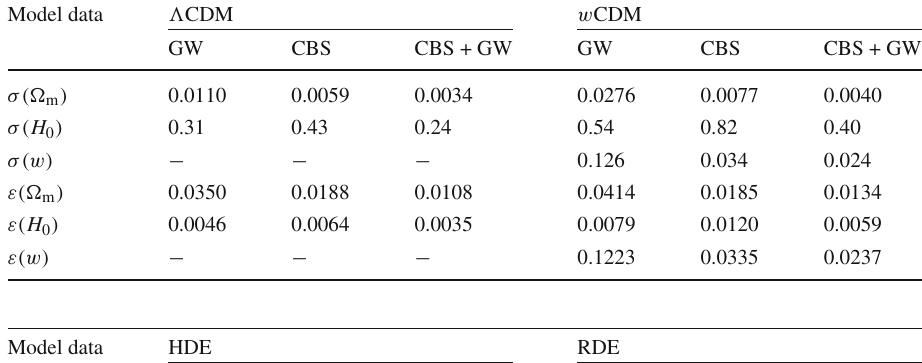
accuracies for cosmological parameters of the HDE model and the RDE model using GW, CBS, and CBS + GW. Here, CBS stands for CMB + BAO + SN; H 0 is in units of km s −